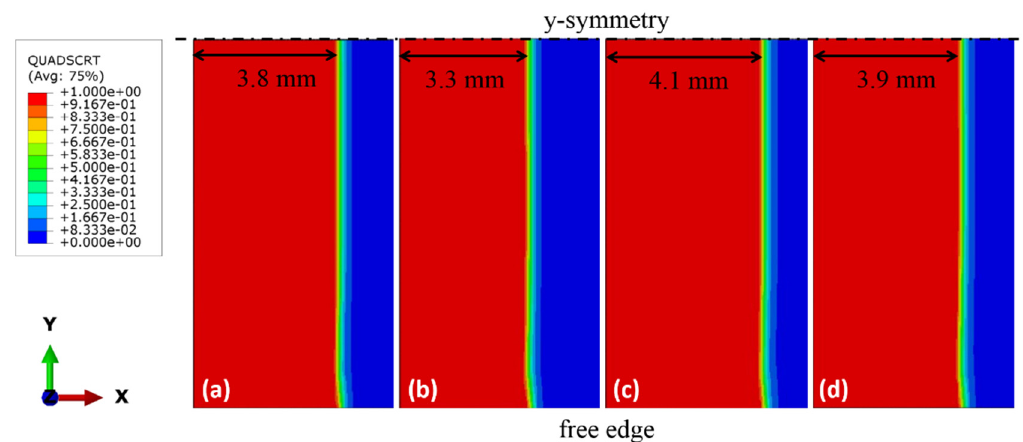
Figure 12. Crack growth profile at peak force for ( a ) 1 mm/min, ( b ) 10 mm/min, ( c ) 100 mm/min and ( d ) 500 mm/min cases.